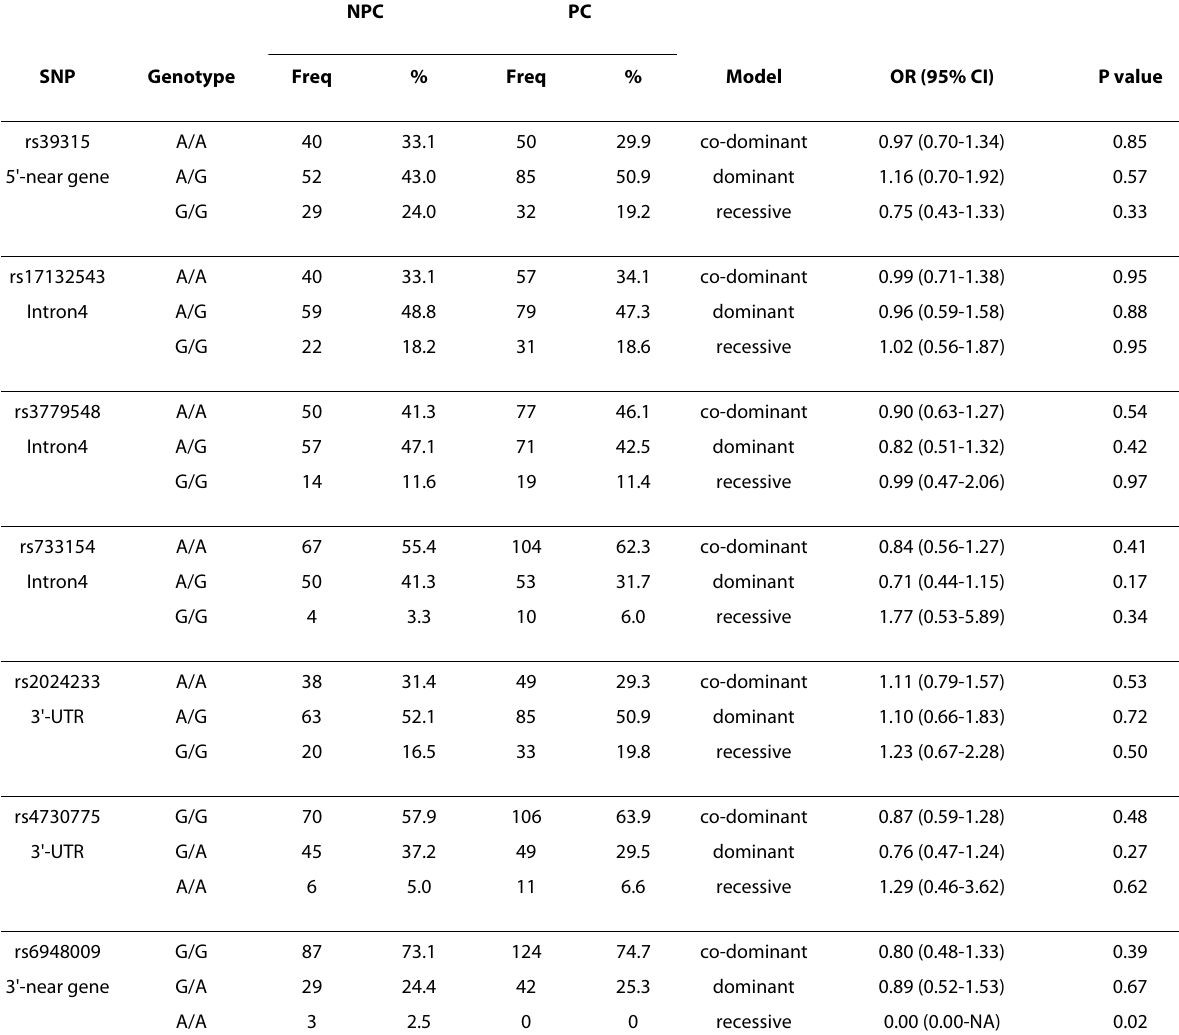
Table 4: WNT2 genotype frequencies in Korean schizophrenia patients with poor concentration